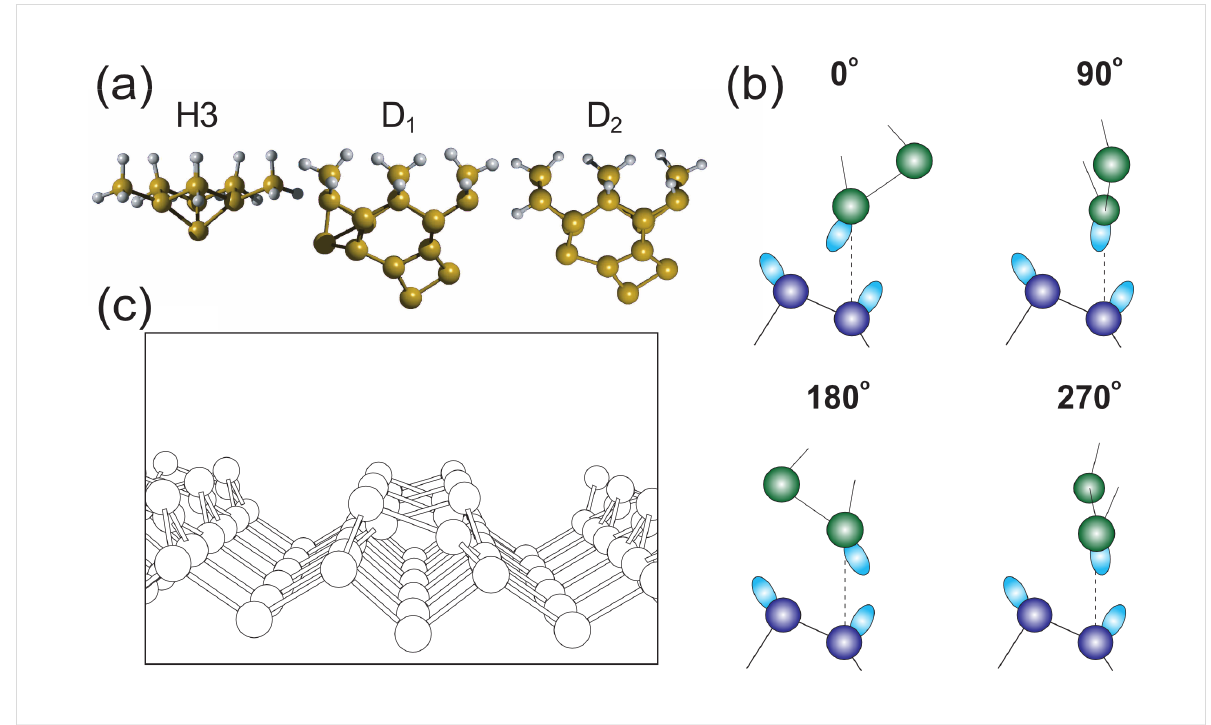
Figure 1: The three tip structures considered, a structurally rigid ‘H3’ termination, and two dimer-terminated tips, are shown in (a). D 1 is relaxed with an additional stabilising atom as compared to D 2 . (b) F ( z ) was calculated for four rotations of the dimer tips with respect to the surface dimers. Note that due to the symmetry of the surface 90° and 270° are equivalent, but are still calculated independently for control. (c) A ball-and-stick model of the upper layers of the Si(100)-c(4×2)